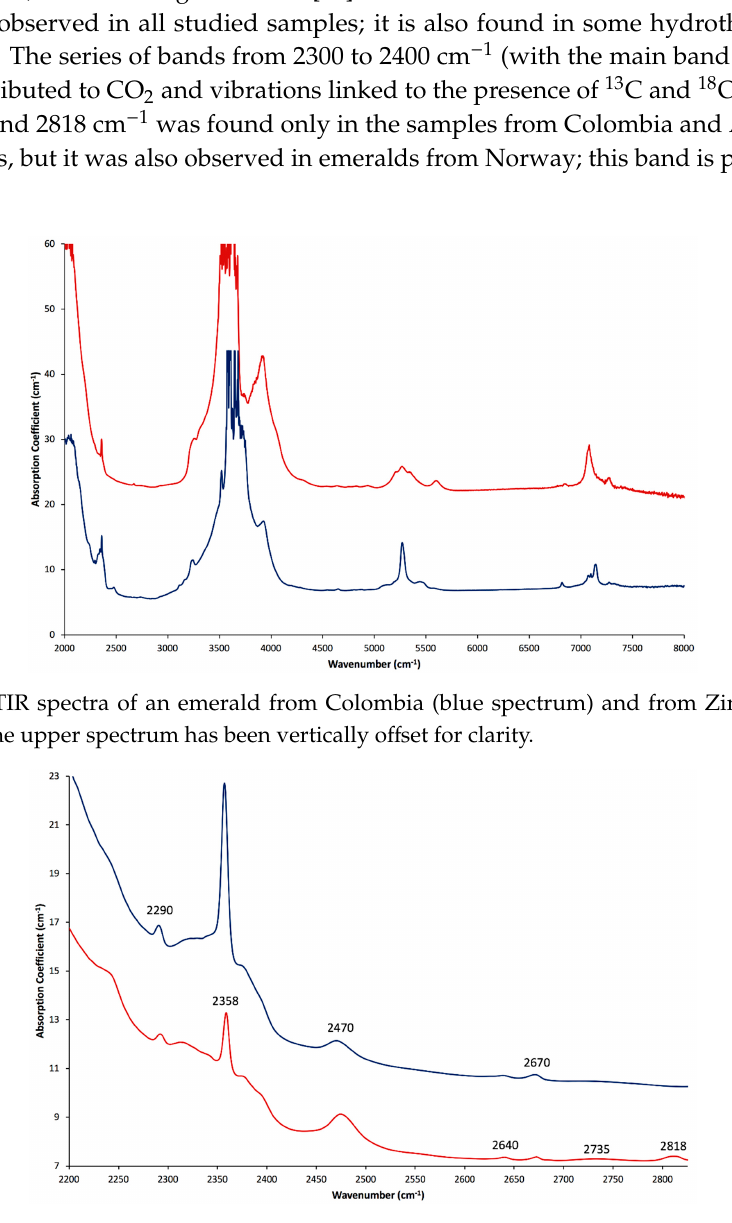
Figure 20. FTIR spectra of an emerald from Colombia (blue spectrum) and from Zimbabwe (red spectrum). The upper spectrum has been vertically offset for clarity.